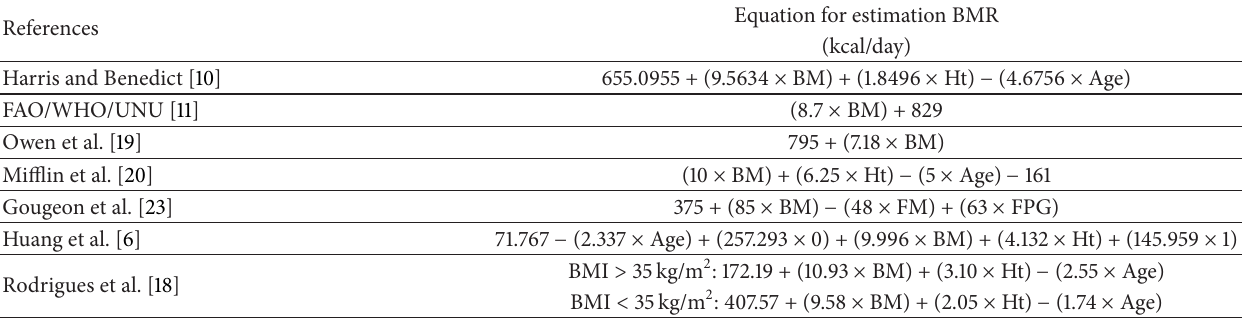
Table 1: Selected prediction equations for estimating basal metabolic rate in women with type 2 diabetes mellitus.